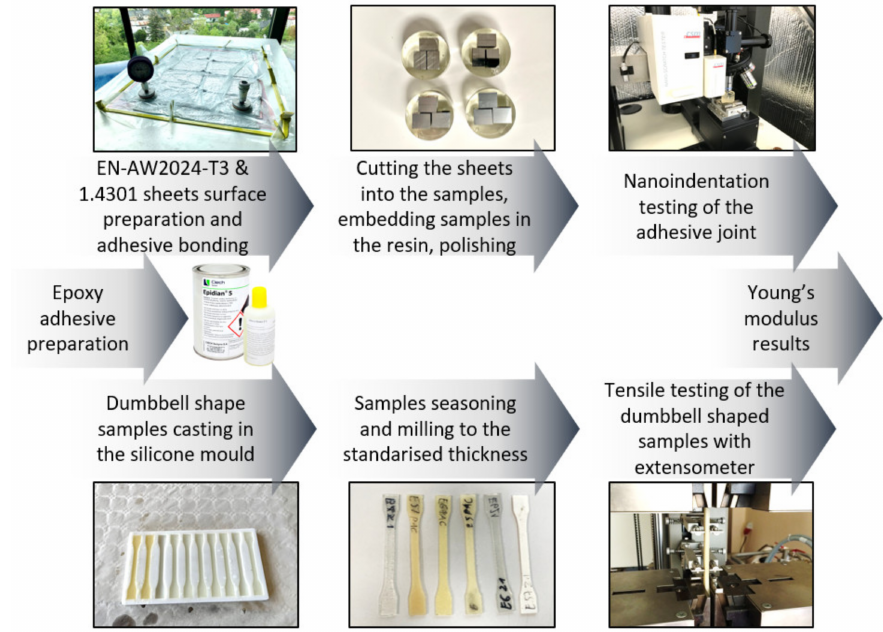
Figure 1. Schematic diagram of the testing procedure.